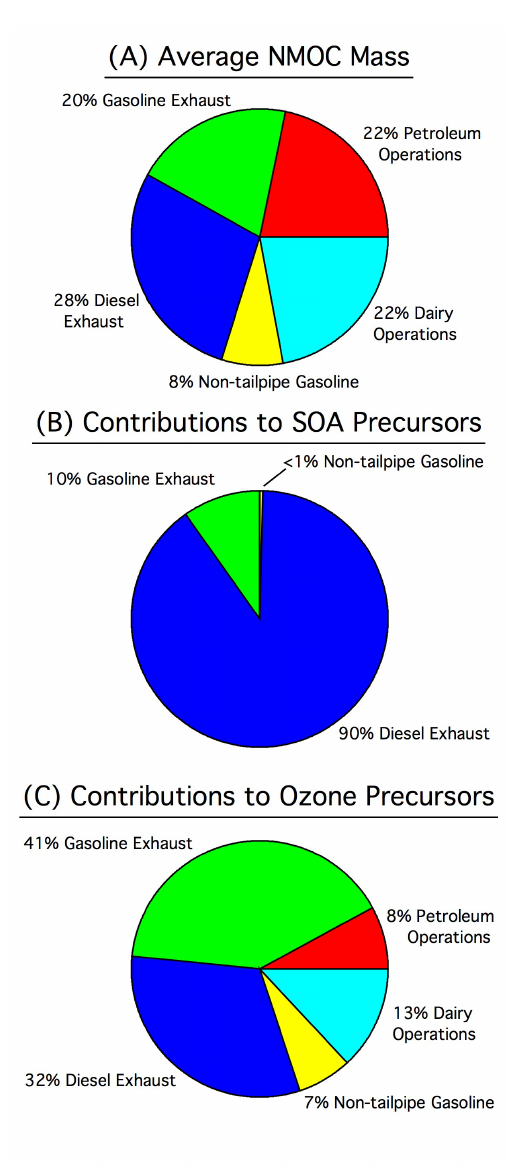
Figure 15. Breakdown of the contributions of prominent anthro- pogenic sources in Bakersfield for (A) total non-methane or- ganic carbon (NMOC) mass (g), (B) precursors to secondary organic aerosol (SOA), and (C) precursors to ozone. Other sources/compounds may impact SOA formation indirectly via changes in photochemistry. The exhaust values here include un- burned fuel emissions and products of incomplete combustion, and dairy operations include other cattle farming. Biogenic emissions from natural vegetation are excluded, but are likely to have impor- tant contributions to emissions and air quality in the San Joaquin Valley, but less so in the urban core of Bakersfield, CA. Note: the NMOC mass comparison in panel A is in terms of mass (similar to inventories), so ratios of sources will be slightly different from Table 5 where they are in mol